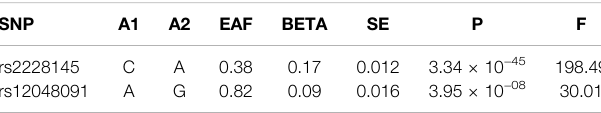
TABLE 1 | Genetic associations with serum interleukin-6 level and F